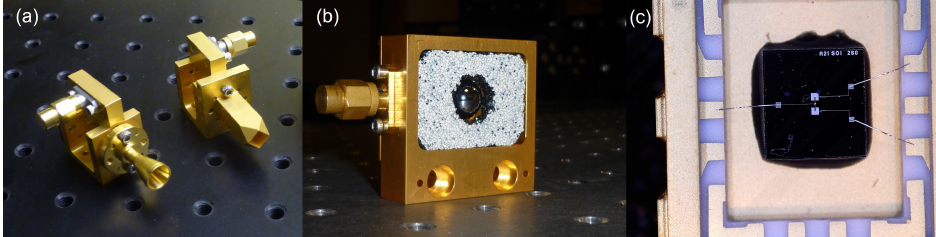
Figure 1. Photographs of the detectors used in the experiments: ( a ) Schottky diodes in the waveguides with horn antennas (two different waveguides inside); ( b ) Schottky diode with hemispherical lens and ( c ) field-effect transistor with patch